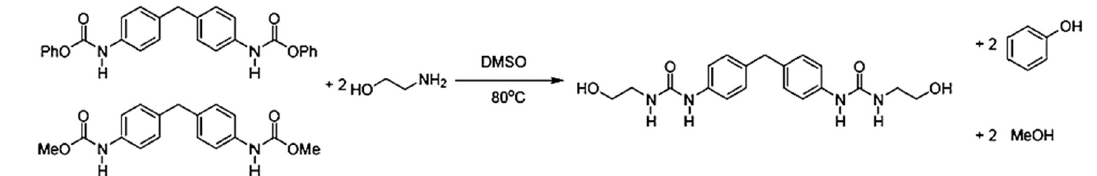
Polymers 2021 , 13 , x FOR PEER REVIEW Figure 34. Synthesis of 4,4 (cid:48) diphenylmethanbis-[(2-hydroxyethyl)urea].(Model trans-ureation reaction). From reference [17]. Figure 34. Synthesis of 4,4 ′ diphenylmethanbis-[(2-hydroxyethyl)urea].(Model trans-ureation reaction). From reference Figure 34. Synthesis of 4,4 ′ diphenylmethanbis-[(2-hydroxyethyl)urea].(Model trans-ureation reaction). From reference [17]. [17].